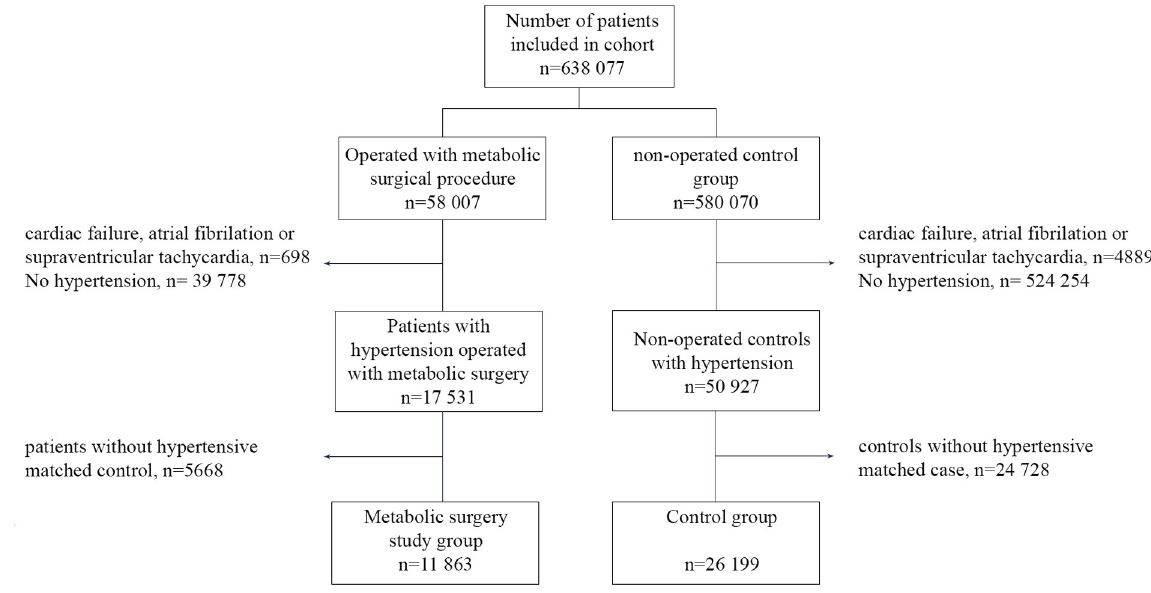
Fig 1. Flow chart. Flow chart describing study